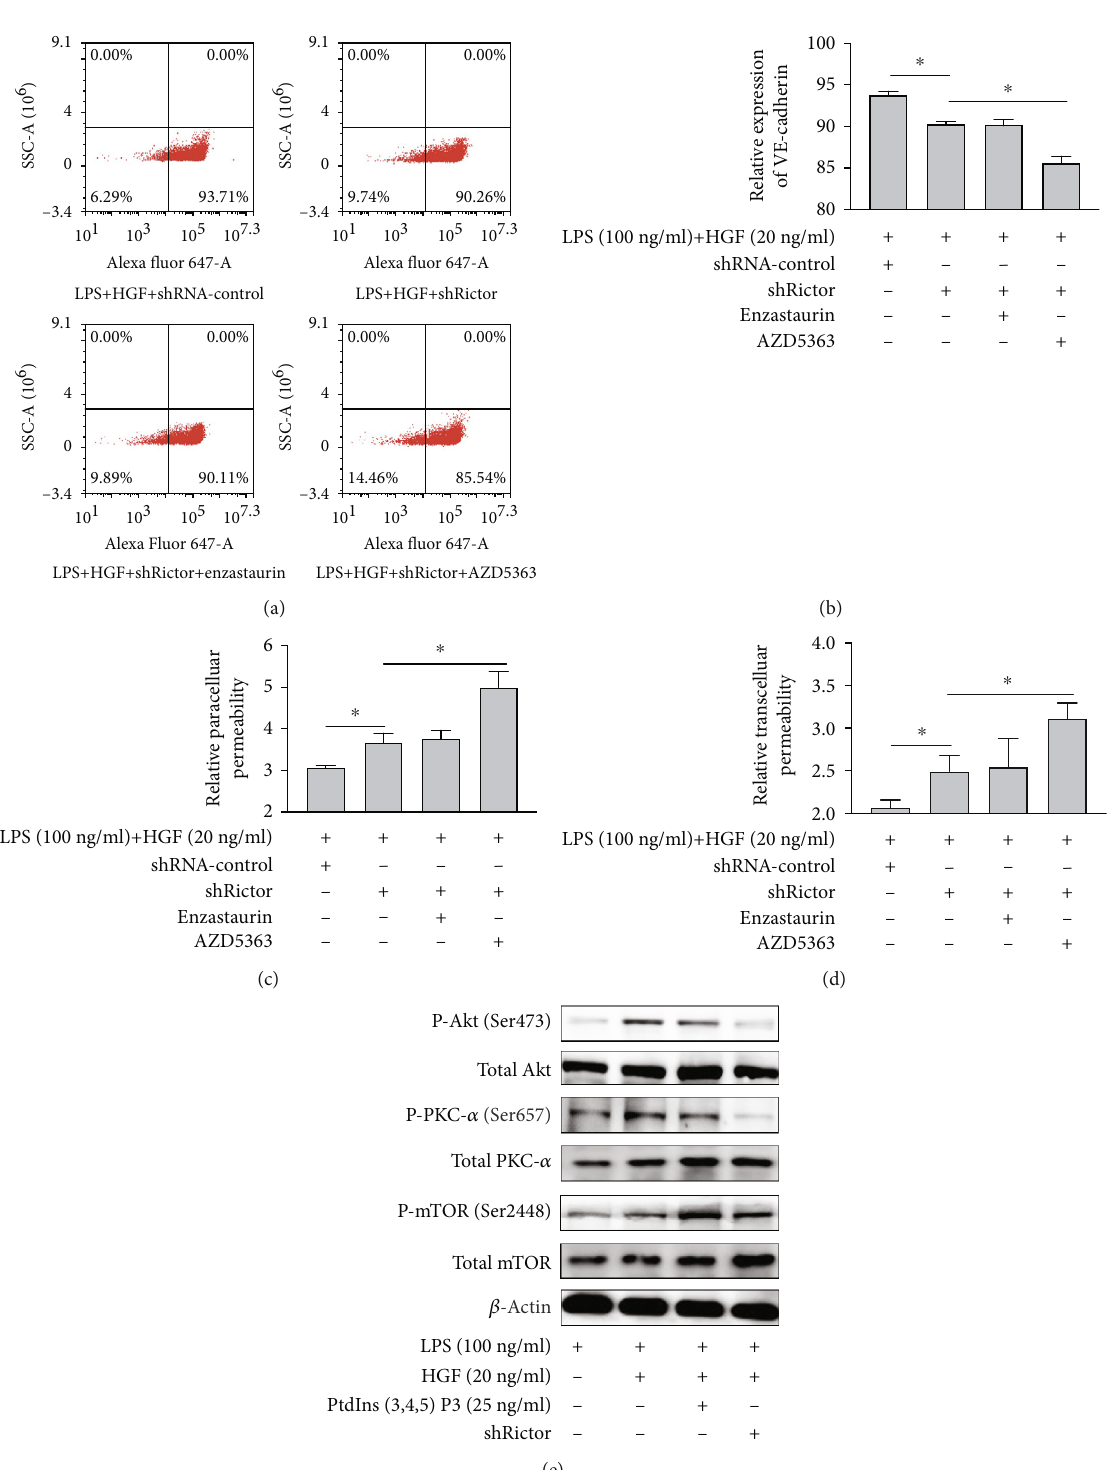
Figure 5: E ff ects of mTORC2/Akt and mTORC2/PKC signaling to HGF on endothelial barrier in LPS-induced PMVECs. PMVECs were treated with HGF (20ng/ml), with or without stimulation with LPS (100ng/ml) for 24h. And enzastaurin (2 μ M) and AZD5363 (1 μ M) were, respectively, used as PKC and Akt inhibitors. PtdIns(3,4,5)P3 (25ng/ml) was used to active mTORC2 as positive control. (a) Flow cytometry scatter plot of 4h VE-cadherin expression with HGF in LPS-induced PMVECs under Akt and PKC inhibition. (b) Flow cytometry cell counts (%) of 4h VE-cadherin expression with HGF in LPS-induced PMVECs under Akt and PKC inhibition. (c) The e ff ects of Akt and PKC inhibitors to relative paracellular permeability of HGF on LPS-induced PMVEC permeability with Alexa Fluor 647-dextran. (d) The e ff ects of Akt and PKC inhibitors to relative transcellular permeability of HGF on LPS-induced PMVEC permeability with Alexa Fluor 647- BSA. Results are mean ± SD ( n = 3 ). ∗ p < 0 : 05 . (e) Evaluation of HGF on the mTORC signaling pathway for western